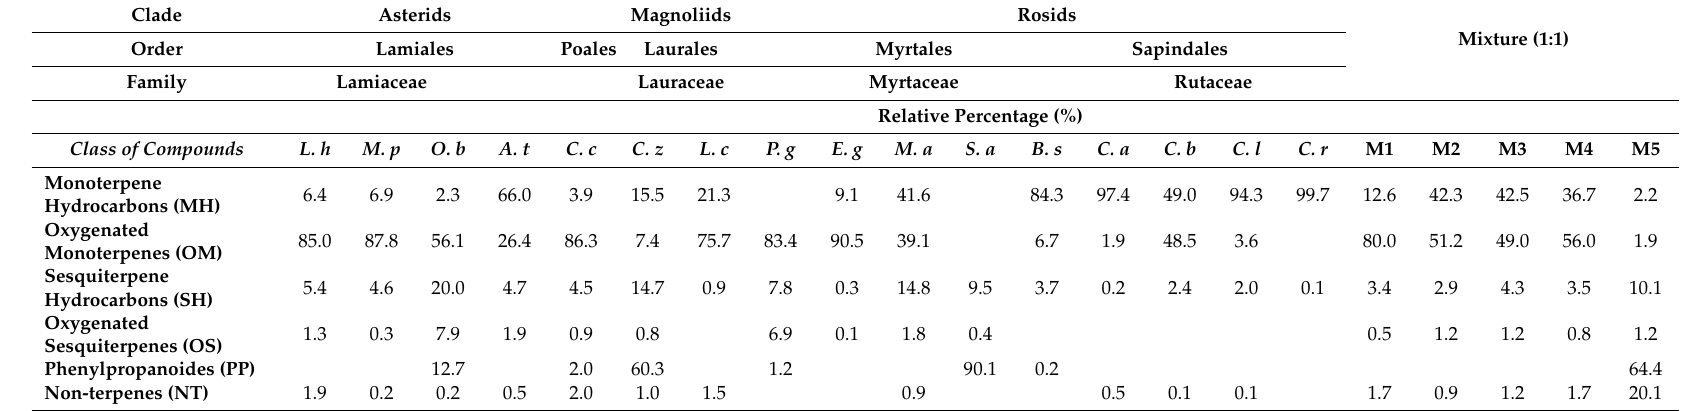
Table 2. Main class of constituents present in the essential oils tested (relative abundance expressed in percentage). Clade